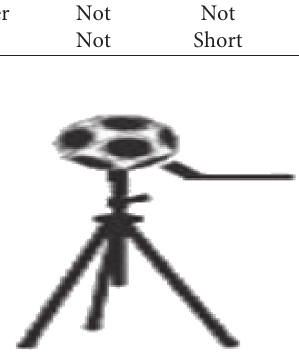
Figure 4: Spherical noise excitation source.